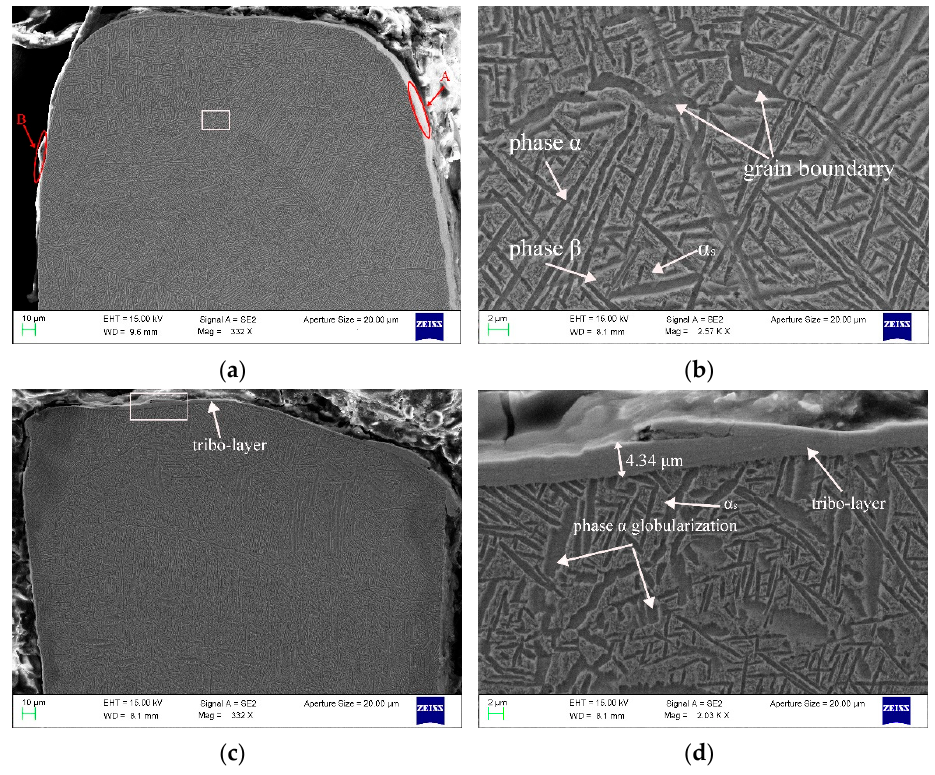
Figure 12. The white arrow and the white circle in Figure 12e indicate the axial incursion direction and the sliding direction respectively. There is no tribo-layer on the original seal fin as shown in Figure 12a. It is to be noted that the bright edges in region A as shown in Figure 12a are the materials behind the surface because the specimen is slightly tilted. The region B in Figure 12a is the inlay rather than the tribo-layer. The wear of the both sides of the seal fin is uniform and the wear is slight when there is only radial rub as shown in Figure 12c. It can be clearly seen that the wear on the axial rub side is severe and the wear on the non-axial rub side is slight when there is axial rub as shown in Figure 12e,i,j,k. The tribo-layer only covers the top surface of the seal fin when there is only radial rub. However, the tribo-layer covers both the top surface and the non-axial rub side when there is axial rub. The reason for the retention of the tribo-layer on the non-axial rub side can be attributed to the low rubbing forces and temperature on the non-axial rub side. On the axial rub side, no tribo-layer appears. The maximum thickness of the tribo-layer on the top surface of the seal fin is 4.34, 4.05, 9.31, 9.65, 29.09 µ m at 0, 60, 80, 100, 120 µ m/s respectively, as shown in Figure 12d,f,g,h,l. Except that the thickness of tribo-layer at 60 µ m/s is less than that with only radial rub, the thickness of tribo-layer at other axial incursion rates is thicker than that with only radial rub and the tribo-layer thickness increases with the axial incursion rate. However, the tribo-layer is not a whole as shown in Figure 12l. The tribo-layer can be divided into two parts: the top tribo-layer and the bottom tribo-layer. The voids appear between the top tribo-layer and the bottom tribo-layer, which indicates that the top tribo-layer and the bottom tribo-layer are not firmly adhered together. Relatively, the adhesion between the bottom tribo-layer and the substrate is firm. As a result, the top tribo-layer will be easily peeled off during the rub while the bottom tribo-layer is hard to be peeled off and retains on the seal fin. However, cracks still exist in the bottom tribo-layer as shown in the white circle in Figure 12l, which indicates that the bottom tribo-layer also may be peeled off under high load. It is to be noted that the initial contour of the tribo-layer is the red dotted line in the Figure 12h. The spalling of tribo-layer is caused by grinding during metallographic sample preparation. This also proves that the top tribo-layer is easily peeled off.